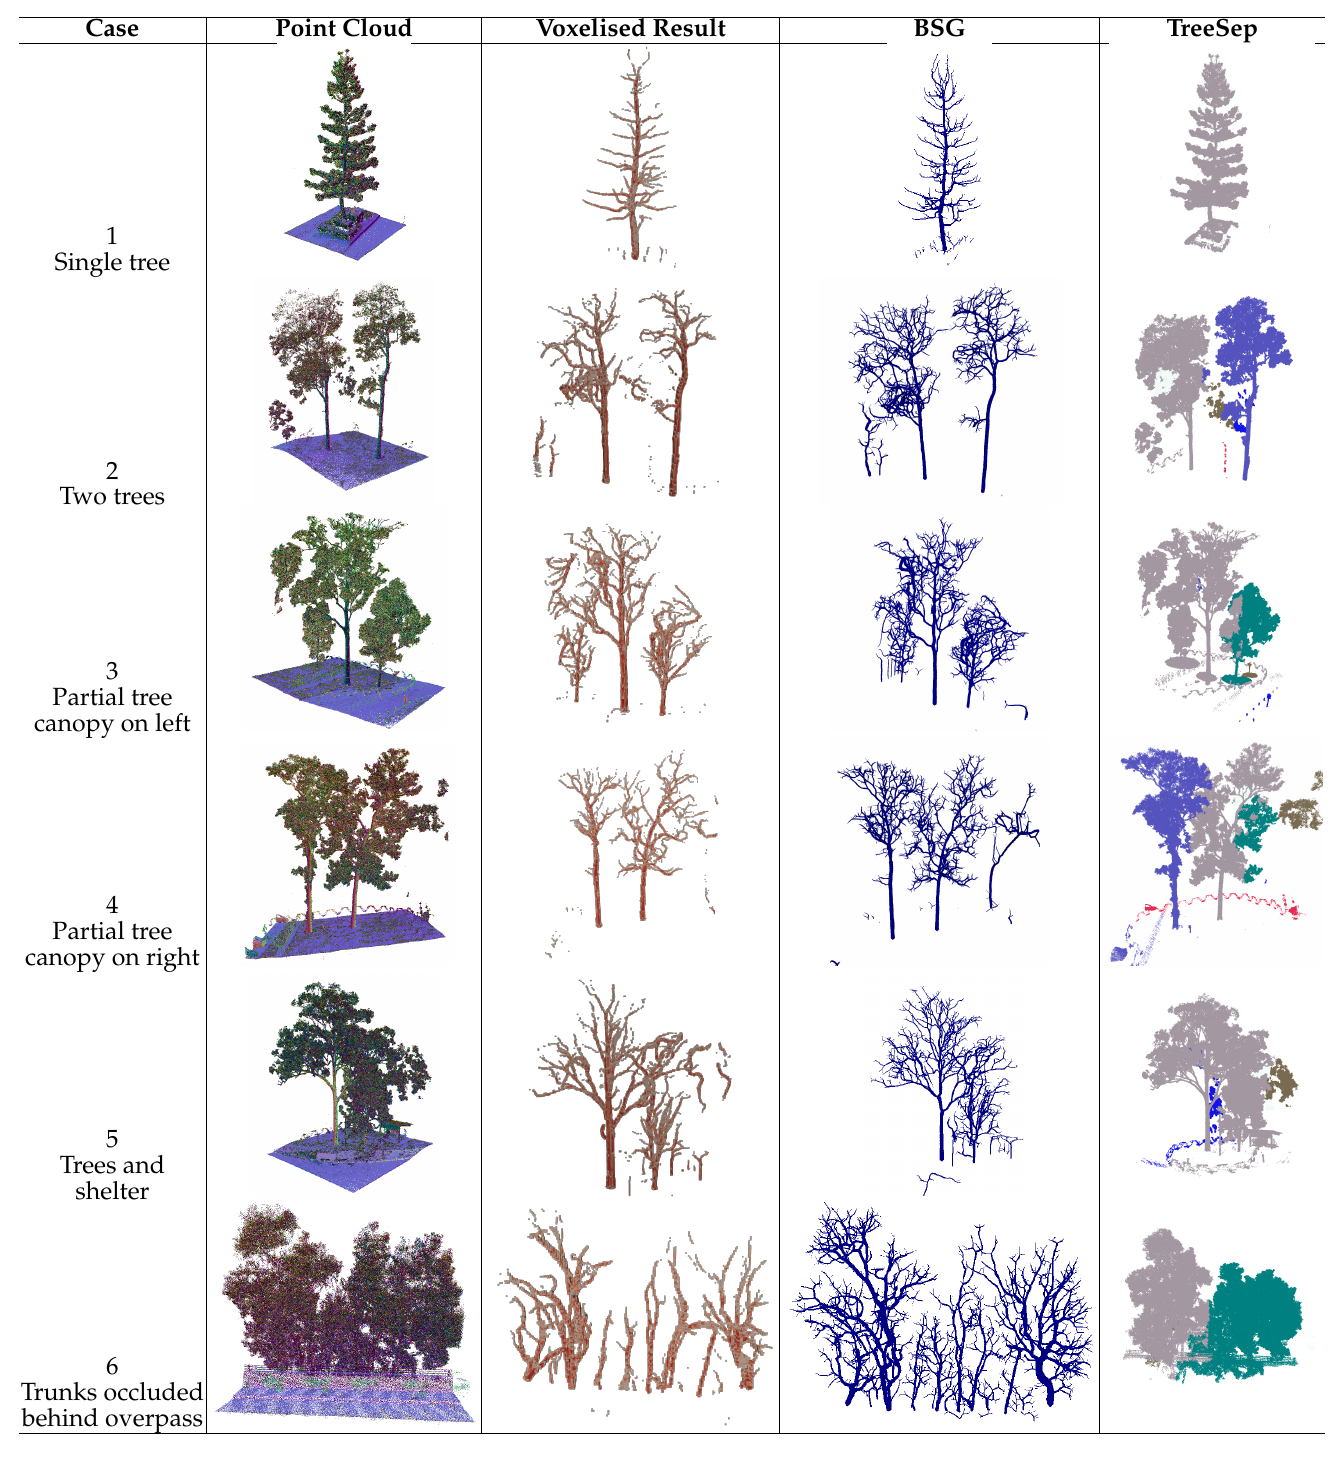
Table 1. Qualitative results (Part 1), showing the original point cloud, topology optimised voxel representation of the tree, and the reconstructed branch structure graph. The segmented trees produced by TreeSep [12] are presented for